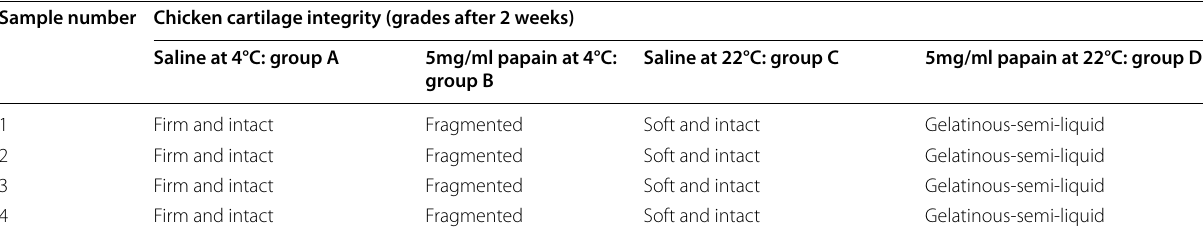
Table 1 Integrity of chicken cartilage at 4°C and 22°C (room temperature) after incubation with 5mg/ml papain or saline after 2 weeks Sample number Chicken cartilage integrity (grades after 2 weeks) Saline at 4°C: group